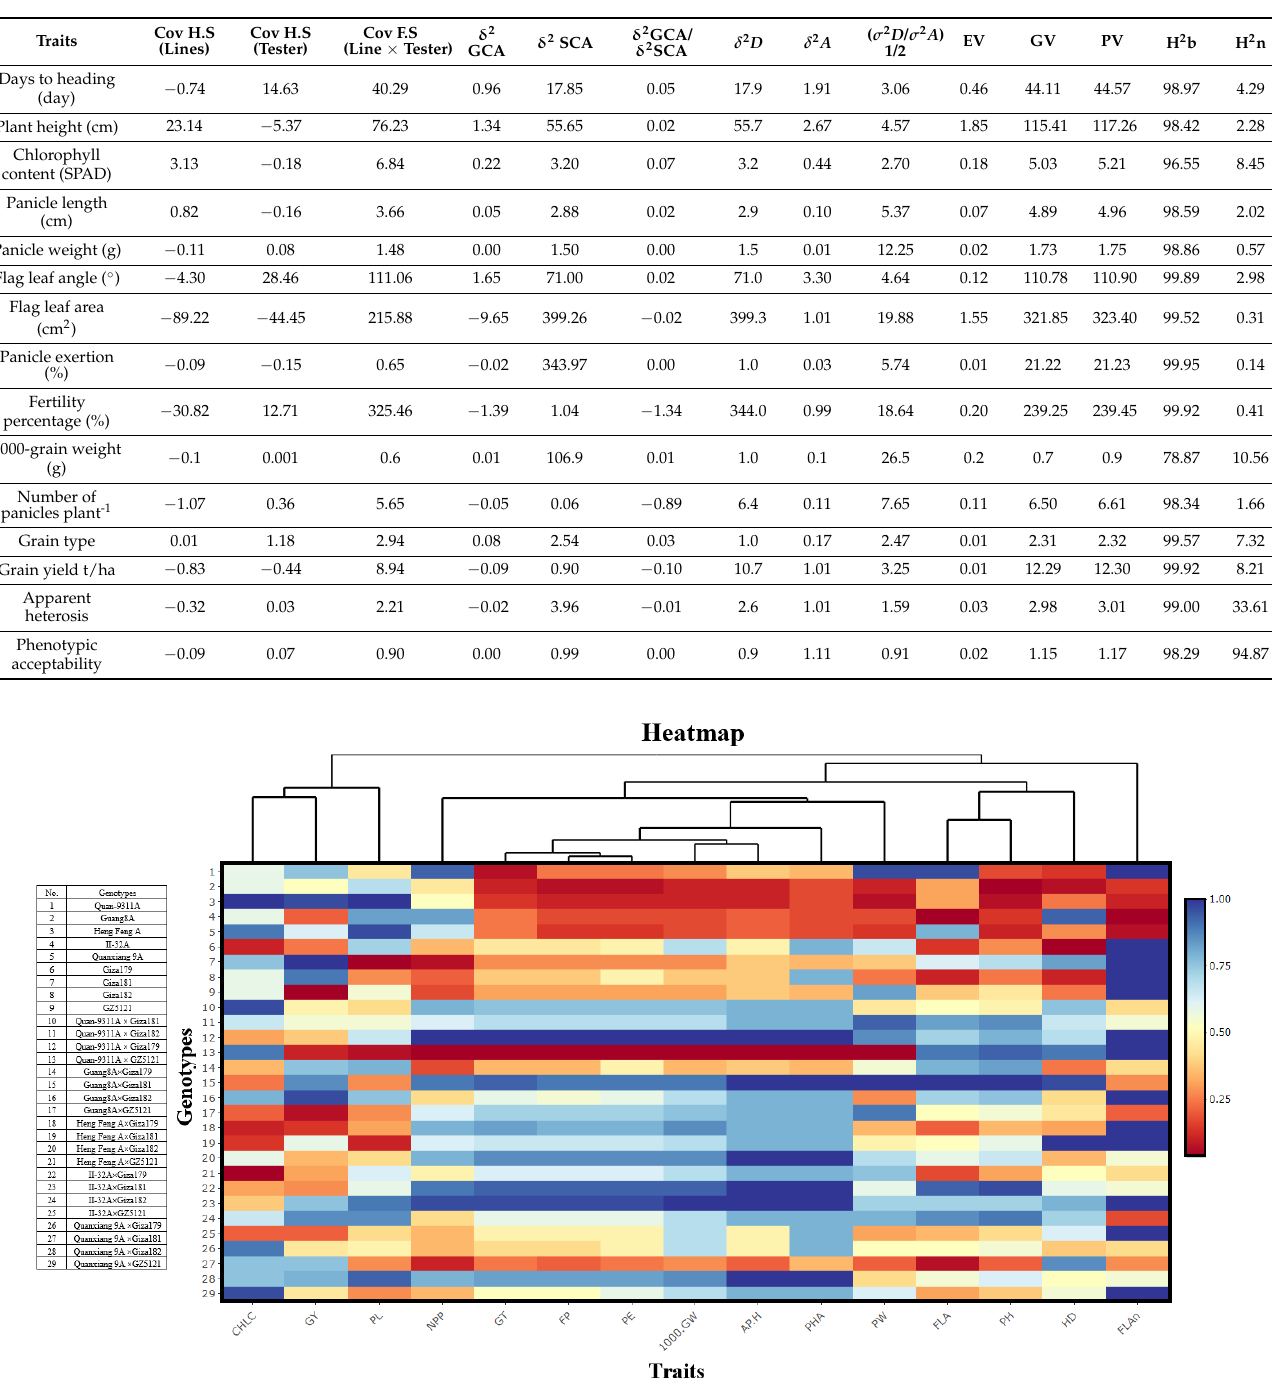
Table 2. Genetic parameters for 15 yield characteristics of tested genotypes.